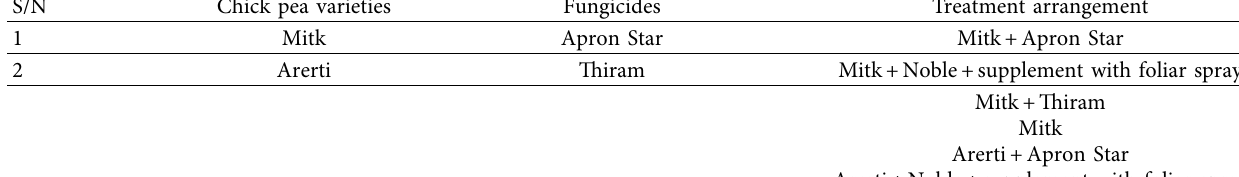
Figure 1: Maps of the study areas showing experimental districts in North Wollo (Lasta Lalibella district) and Waghimra zone (Sekota zuria district), Amhara, Ethiopia, during the 2020 cropping Table 1: Treatments and the arrangement of chick pea varieties and different seed-dressing fungicides with foliar supplement of Noble. S/N Chick pea varieties Fungicides Treatment arrangement Mitk Apron Star